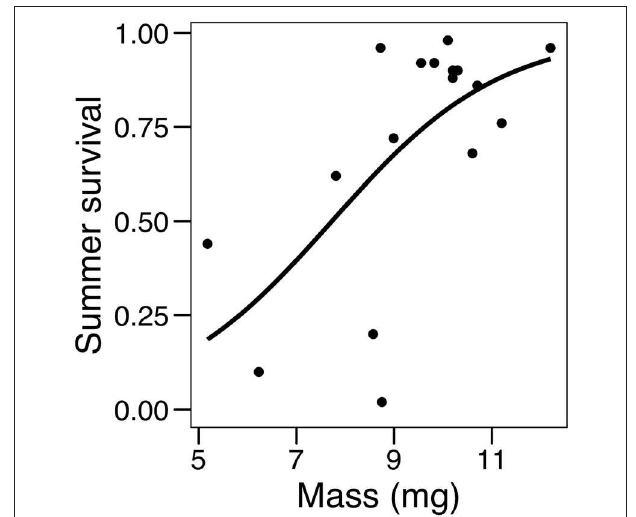
FIGURE 8 | Logistic regression showing the effect of mean larval mass on summer survival (proportion of dormant larvae surviving to the end of